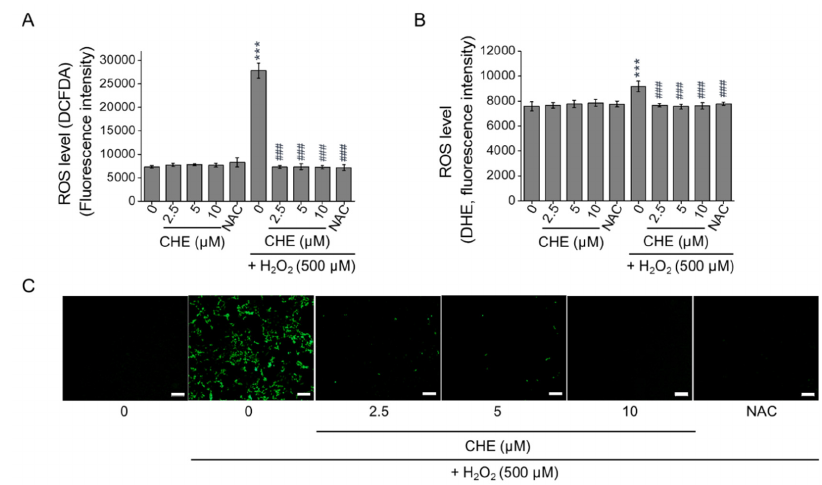
Figure 2. Protective effects of CHE against H 2 O 2 -induced ROS generation in ARPE-19 cells. Cells were pre-treated with 2.5, 5, or 10 µ M CHE or 0.1% DMSO (vehicle control) for 2 h and then incubated with or without 500 µ M H 2 O 2 for an additional 24 h. Afterward, ROS levels were measured by using DCFDA ( A ) or DHE ( B ). Representative images of the cells evaluated by DCFDA staining. ( C ) N -acetyl-cysteine (NAC, 4 mM) was used as an antioxidant control. *** p < 0.001, versus the control group; ### p < 0.001, versus the H 2 O 2 -treated group. Scale bar: 100 μ m.